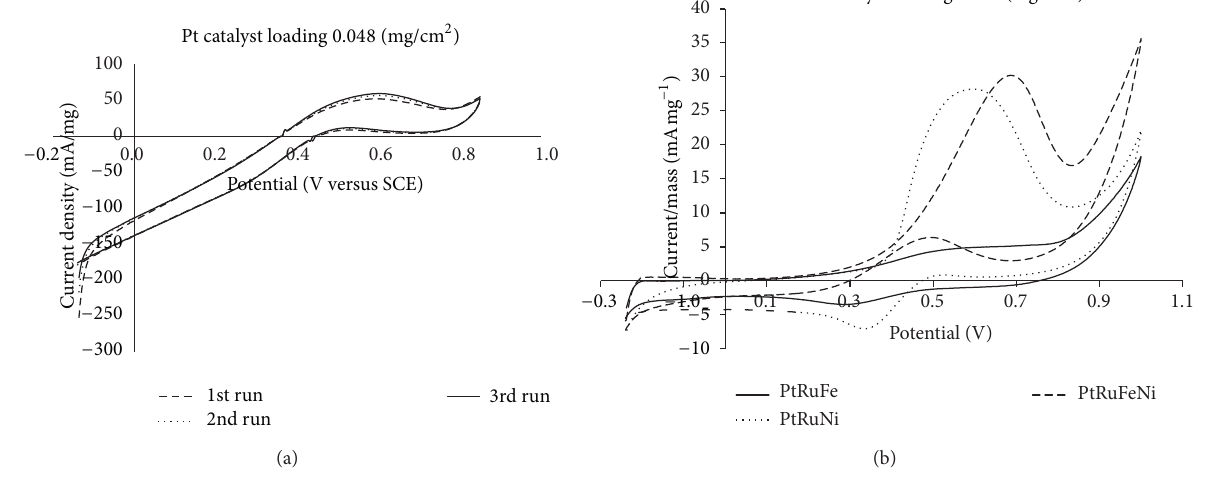
Figure 6: Cyclic voltammetry for MWCNT-based nanocatalyst. Table 3: Summary of the cyclic voltammetry results.